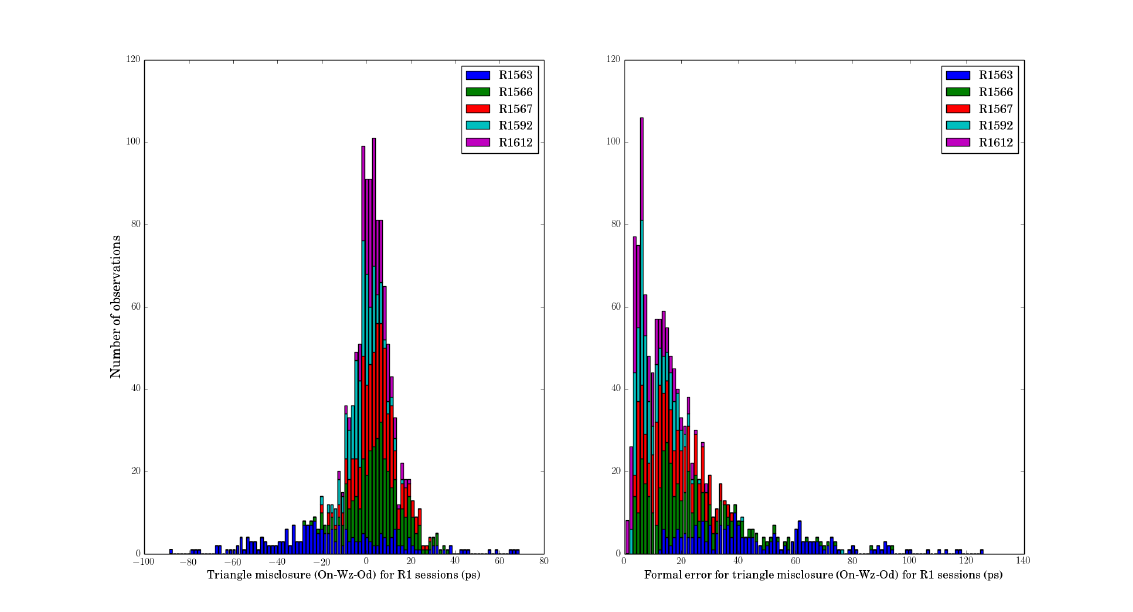
Figure 3: Histograms of the misclosures in the triangle (On-Wz-Od) for the five R1 sessions (left plot) and the corresponding formal errors for the miscloures (right plot). The median absolute values are 14.7 ps and 9.4 ps for the misclosures and the formal errors, respectively.